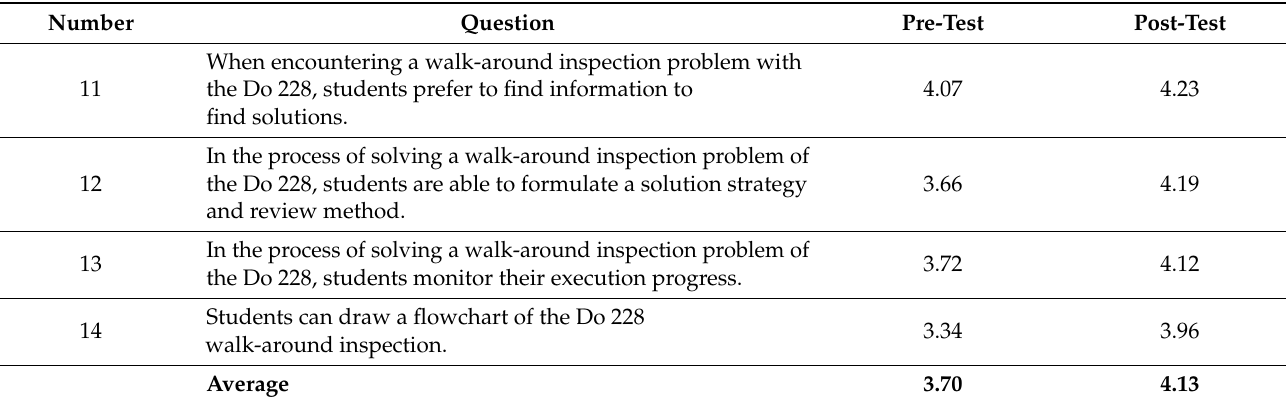
Table 6. The results for the problem-solving